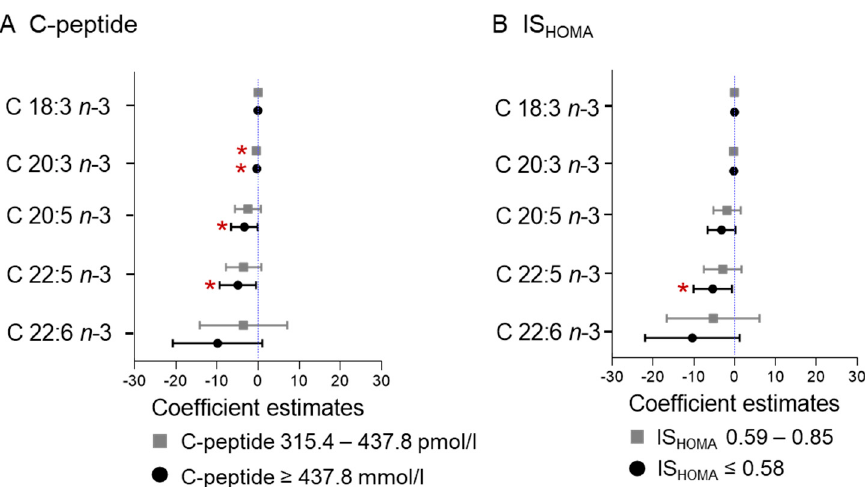
Figure 2. Association of C-peptide and IS HOMA with individual n -3 fatty acids. Measures of maternal C-peptide ( A ) and IS HOMA ( B ) were categorized into tertiles and the estimates compared to the reference category: C-peptide < 315.4 pmol/L, ISHOMA > 0.85. Model adjusted for gestational age (days), maternal age (years), and processing time (minutes). * Statistically significant difference after correction for multiple testing (FDR = 0.2). Table 1. Associations between C-peptide or IS HOMA and fatty acids classes are independent of BMI and leptin. Model 1 Model